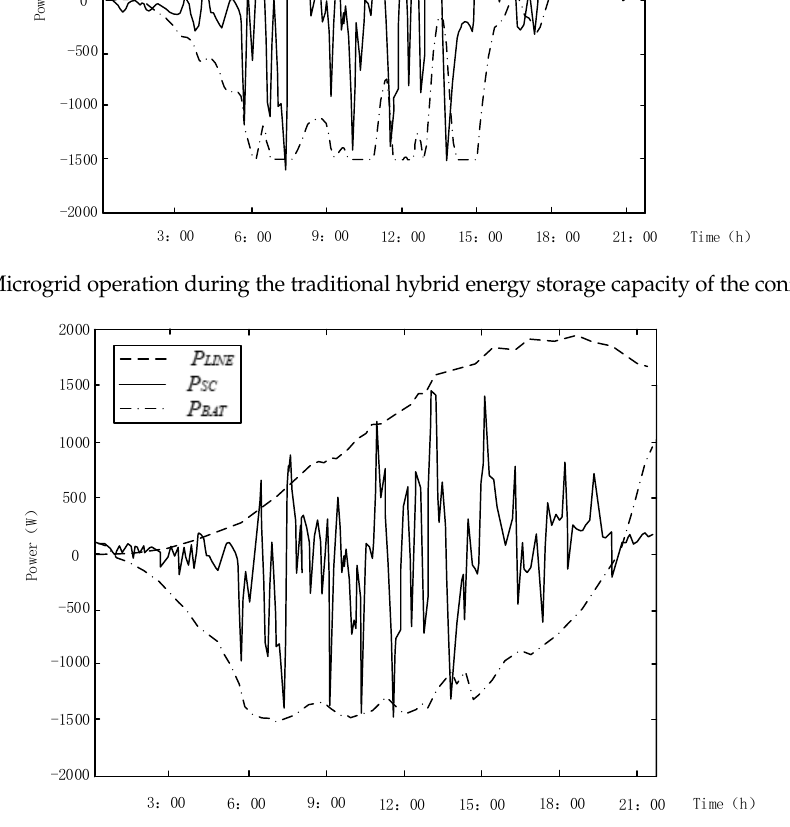
Figure 5. Microgrid operation during the optimized hybrid energy storage capacity of the configuration.